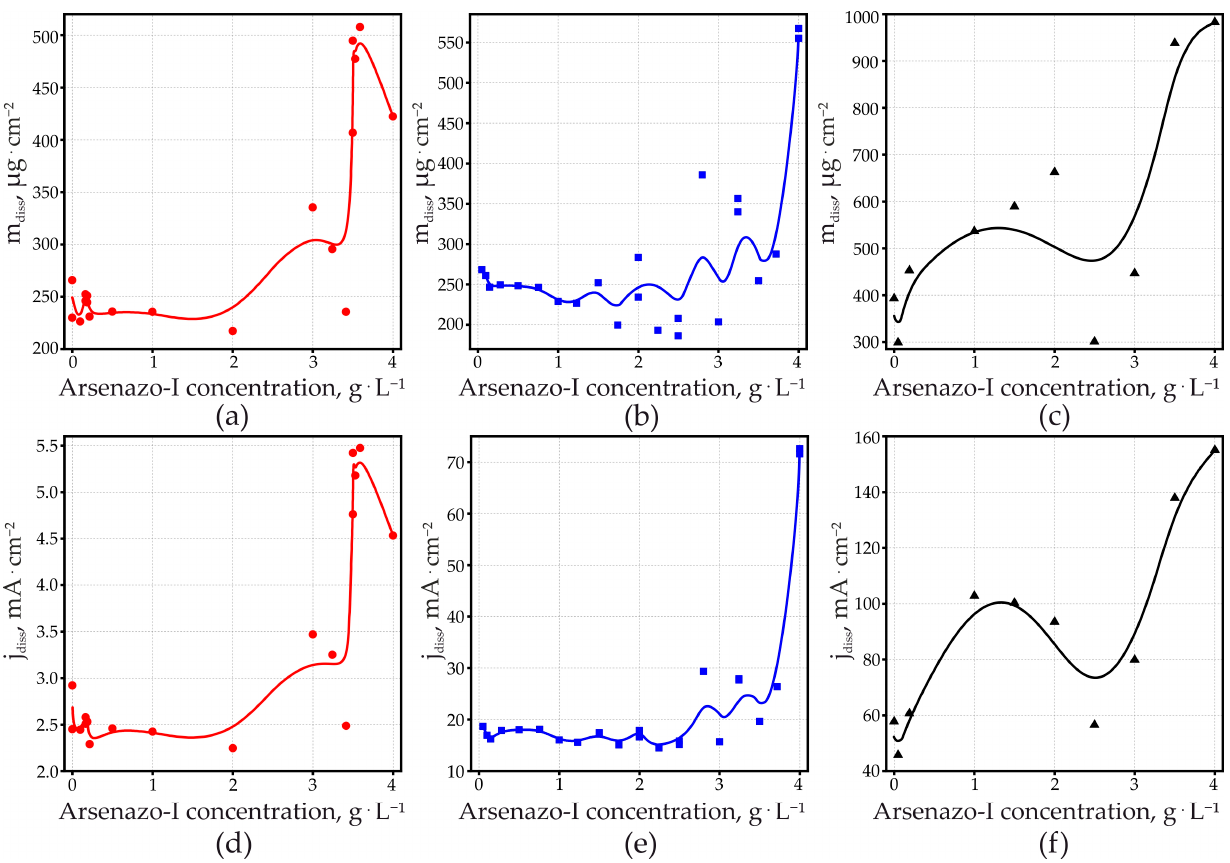
Figure 5. The mass loss per oxide surface area, m diss ( a – c ) for 15, 100, and 200 mA·cm − 2 , respectively, and current density of Al dissolution, obtained from dissolved Al 3+ ( d – f ) for 15, 100, and 200 mA·cm − 2 , respectively, as a function of arsenazo-I concentration for Al in 0.6 M malonic acid.